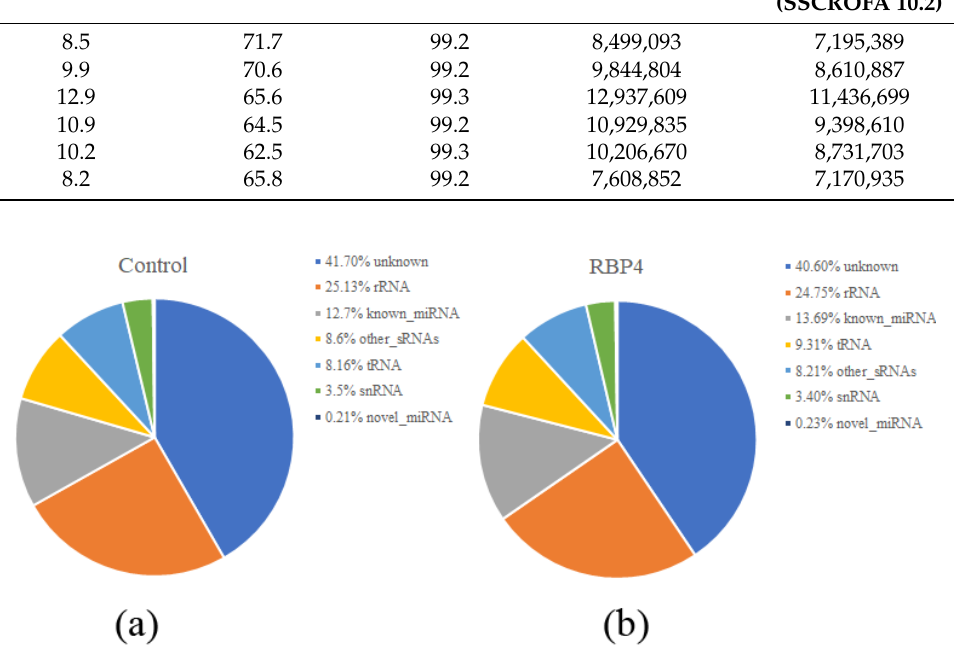
Figure 1. Annotation of sRNA sequences. ( a ) Classification of sRNAs of the control group; ( b ) clas- sification of sRNAs of the RBP4 group.